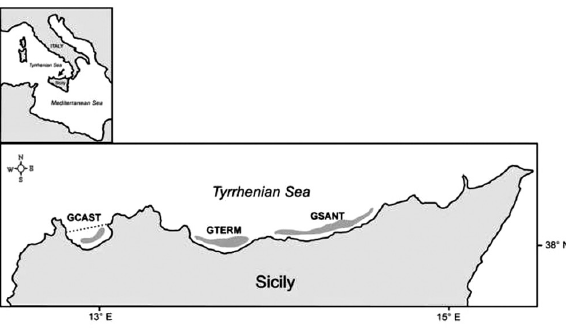
Fig. 1. – Study area; GCAST, Gulf of Castellammare; GTERM, Gulf of Termini Imerese; GSANT, Gulf of S.